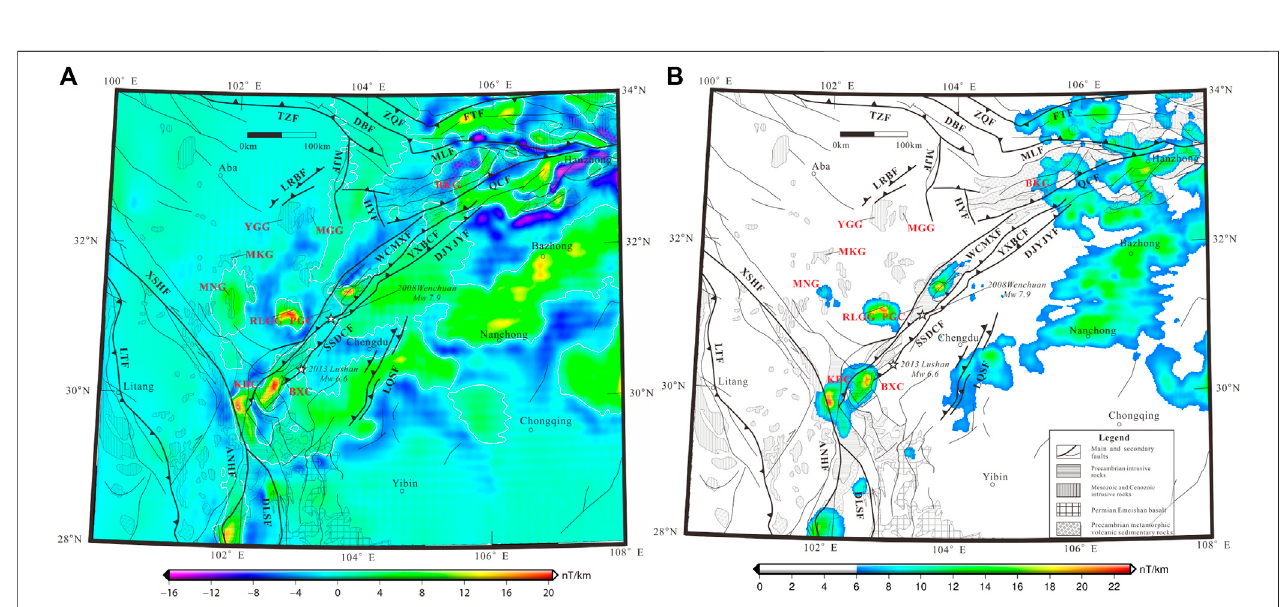
FIGURE 5 | (A) The fi rst vertical derivation map of the RTP anomalies. (B) The analytical signal amplitude of the RTP anomalies. Solid white lines mark the zero- values.